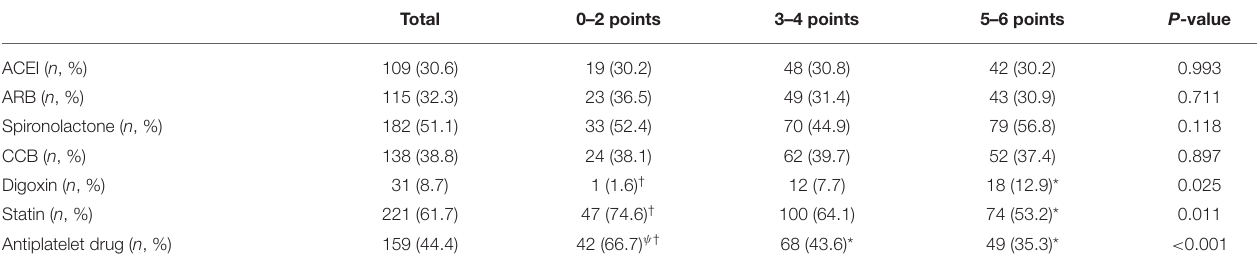
renal failure ( n = 65). In the remaining cohort, the percentages of the low, intermediate, and high score groups were 63 (17.6%), 156 (43.6%), and 139 (38.8%), respectively. The study flowchart is shown in Figure 1